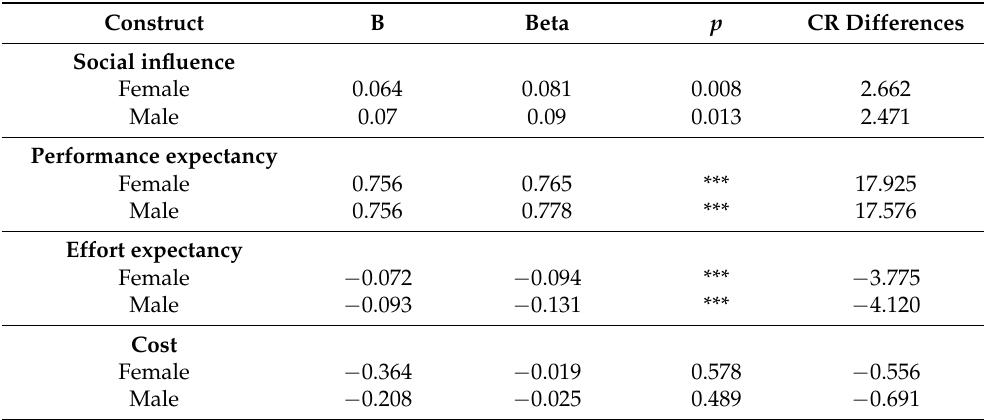
Table 6. Moderation test of the effect of gender on the relationship between intention and con- struct